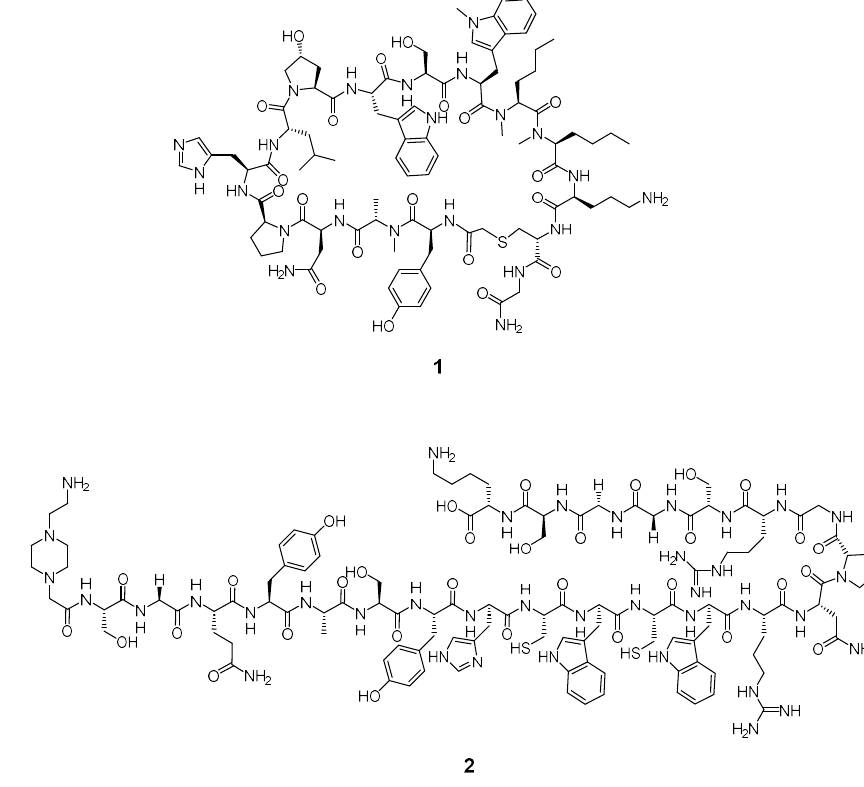
Figure 8. Core structures of the WL12 peptide 1 and native TPP-1 peptide 2.